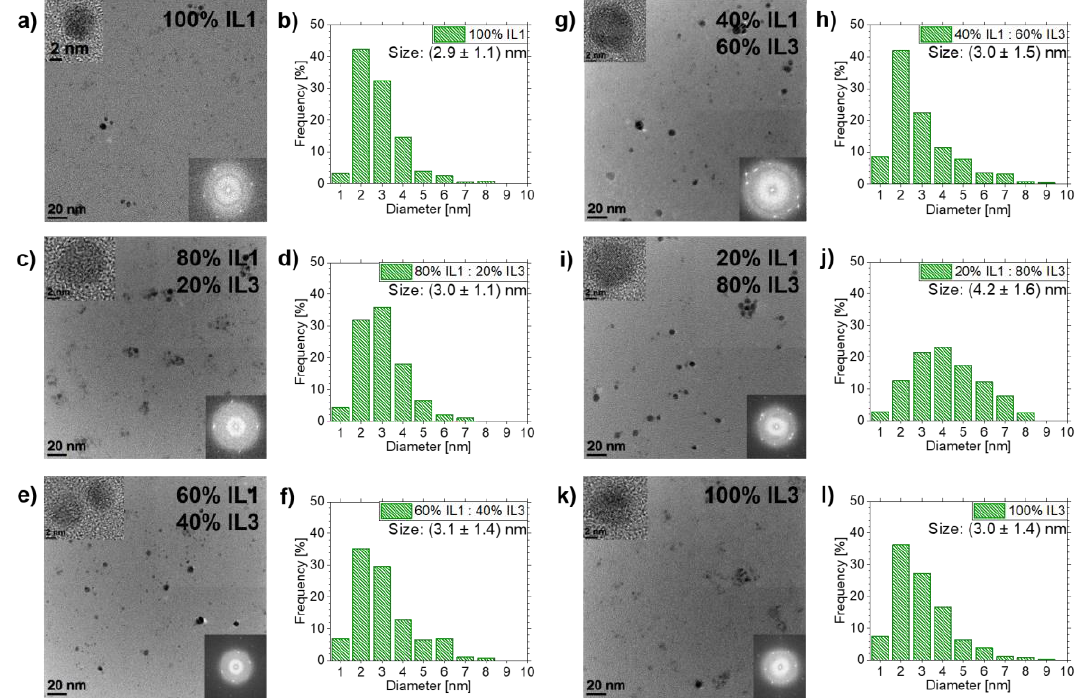
Figure 6. Overview of TEM results of Cu NPs sputtered in IL1 / IL3 -mixtures and pure ILs as references. TEM overview images and the corresponding NP size distribution are depicted in ( a , b ) for IL1 . Overview images and NP size distributions for IL1 / IL3 -mixtures are shown in ( c , d ) for 80 vol.% IL1 / 20 vol.% IL3 , in ( e , f ) for 60 vol.% IL1 / 40 vol.% IL3 , in ( g , h ) for 40 vol.% IL1 / 60 vol.% IL3 and in ( i , j ) for 20 vol.% IL1 / 80 vol.% IL3 . Results of IL3 are illustrated in ( k , l ). HRTEM images of NPs from the investigated IL (mixtures) and corresponding FFT images are depicted as insets in the overview images, confirming the NP crystallinity due to the visible lattice fringes and the corresponding spots in FFTs.